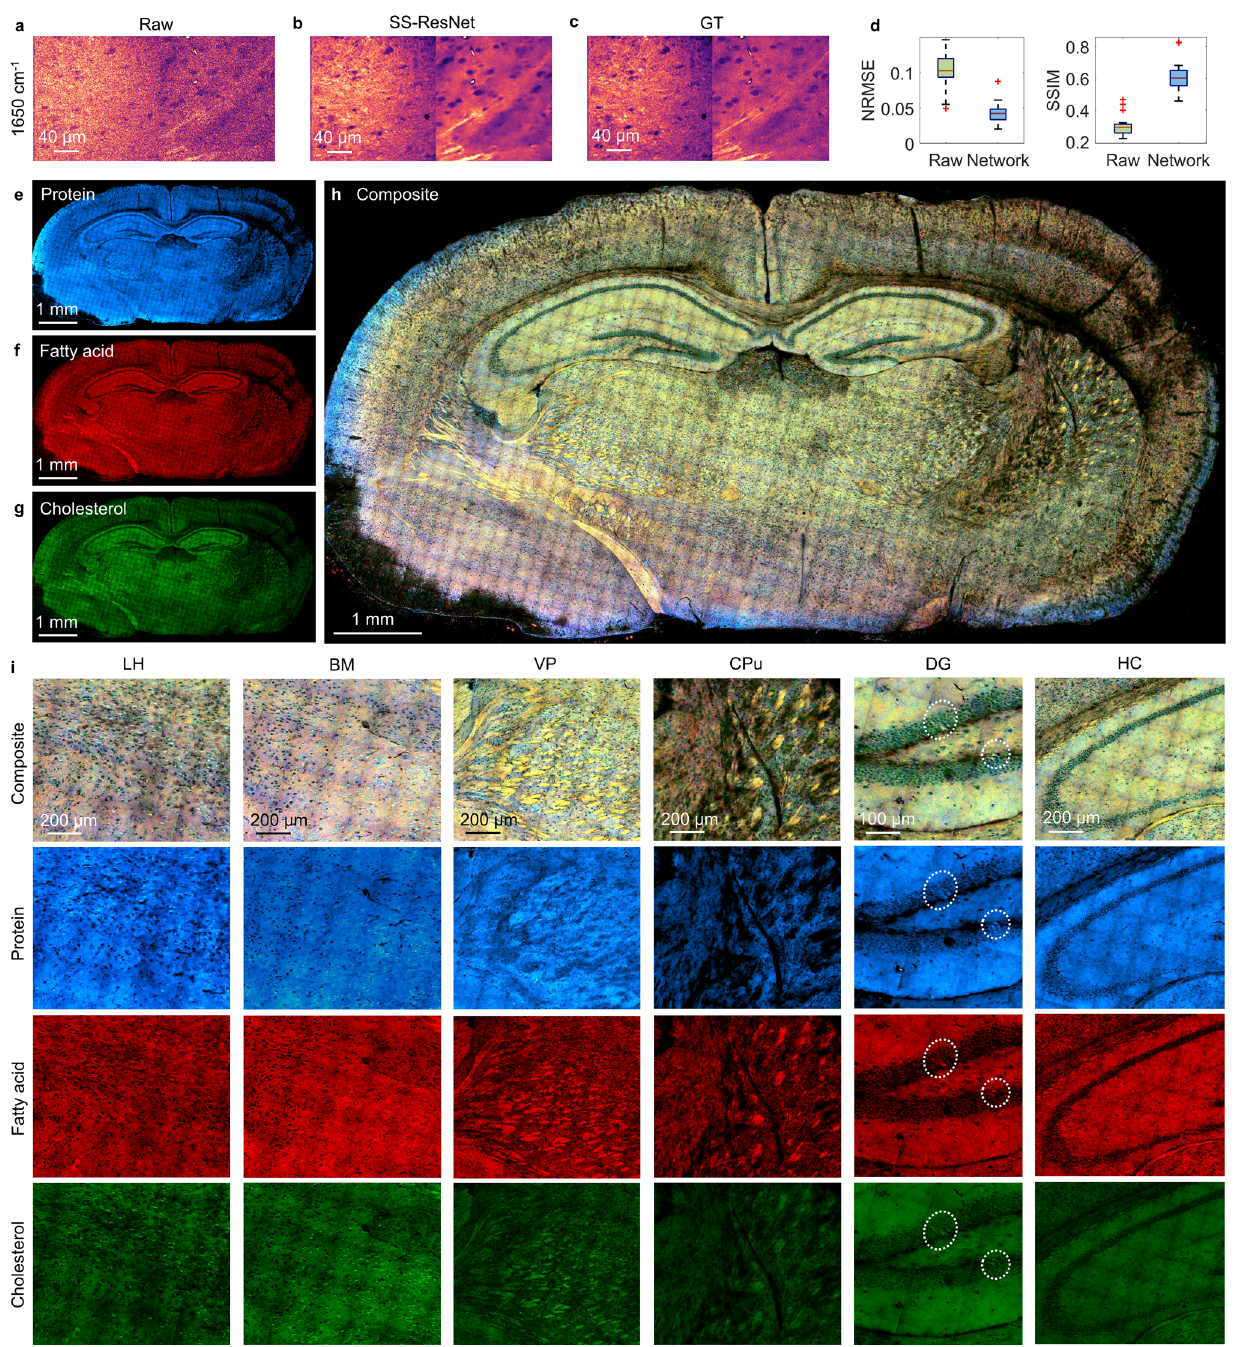
Fig. 3 Spectroscopic fi ngerprint SRS imaging of mouse whole brain. a – c Fingerprint spectroscopic SRS imaging of mouse brain by single raw acquisition, network recovery, and 100 averaging ground truth (GT). d Quantitative analysis of network recovery quality for mouse brain. Box plots ( n = 15) show the NRMSE and SSIM for raw vs. GT and network vs. GT. The boxes show interquartile range (IQR), the red line indicates medians, the black lines represent whiskers which extend to 1.5 times of the IQR and the red data points are the outliers exceeding the whiskers. NRMSE normalized root mean square error, SSIM structural similarity index. e – g Protein, fatty acid, and cholesterol maps of a mouse whole-brain slice after SS-ResNet recovery. h Mouse whole-brain composite chemical maps consisting of protein (blue), fatty acid (red), and cholesterol (green). Different colors indicate different percentage concentrations from the three channels. i Zoom-in images of different mouse brain areas. Circled regions in the DG area include rare cells with high cholesterol content. LH lateral hypothalamus, BM basal amygdaloid, VP ventral posterior nucleus, CPu caudate putamen, DG dentate gyrus, HC